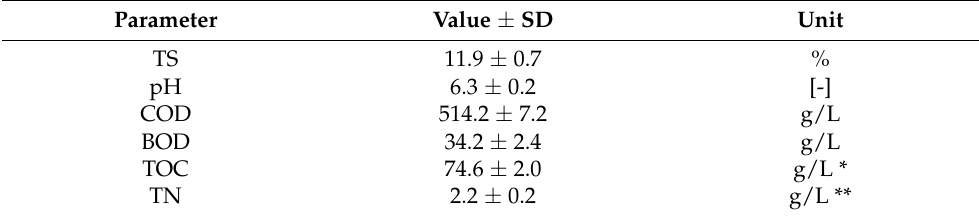
Table 1. Analytical parameters of MIWS.